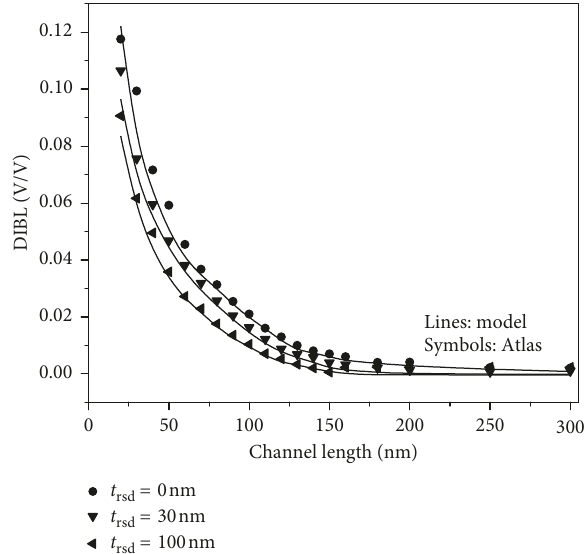
Figure 5: Threshold voltage for different sets of values of work functions for TMG Re-S/D SOI MOSFET.